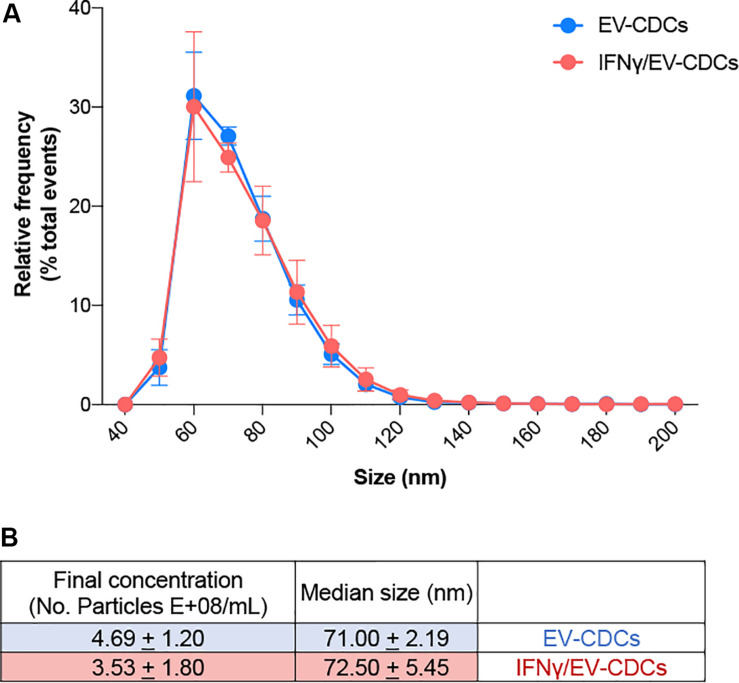
High-sensitivity flow cytometry analysis of extracellular vesicles derived from CDCs (EV-CDCs) at the single-particle level. (A) Histogram of particle size with a bin width of 10 nm for control EV-CDCs (blue, n = 4) and EVs isolated from IFNγ-primed CDCs (IFNγ/EV-CDCs) (red, n = 4) analyzed by NanoFCM. Data show average (±SD) of the relative frequency of total events from representative technical replicates. (B) Concentration and median size values of EV-CDC (n = 4) and IFNγ/EV-CDC (n = 4) samples characterized in this study. Dilution range was tested for every sample, and two technical replicates were recorded for at least 3,000 and up to 12,000 events. Data show the average (±SD) of group samples.